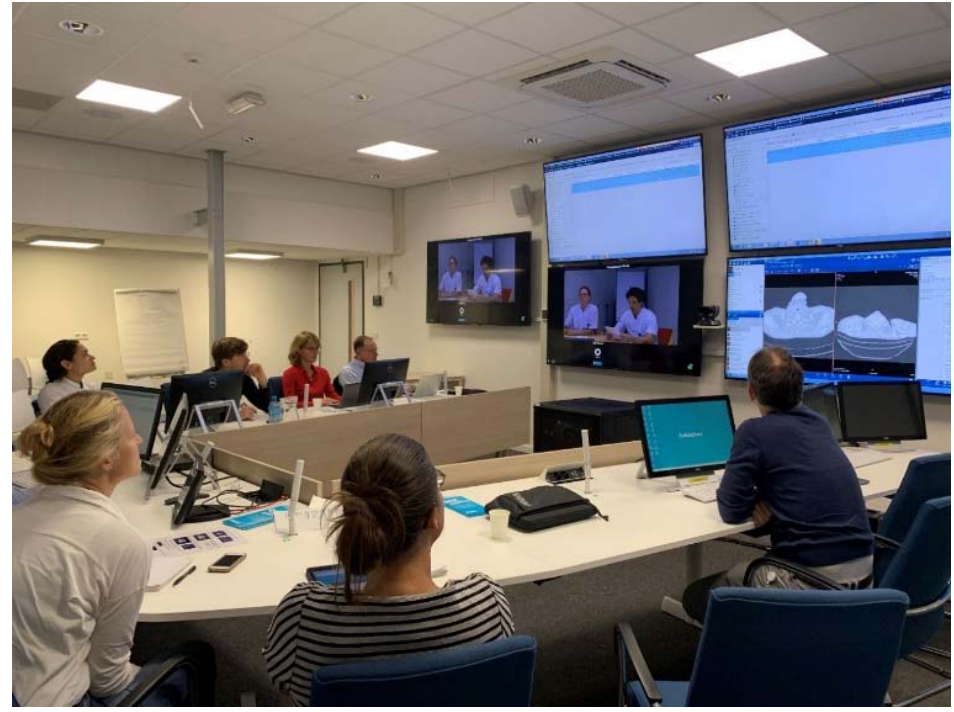
Figure 1. Impression of the multidisciplinary mycology meeting.